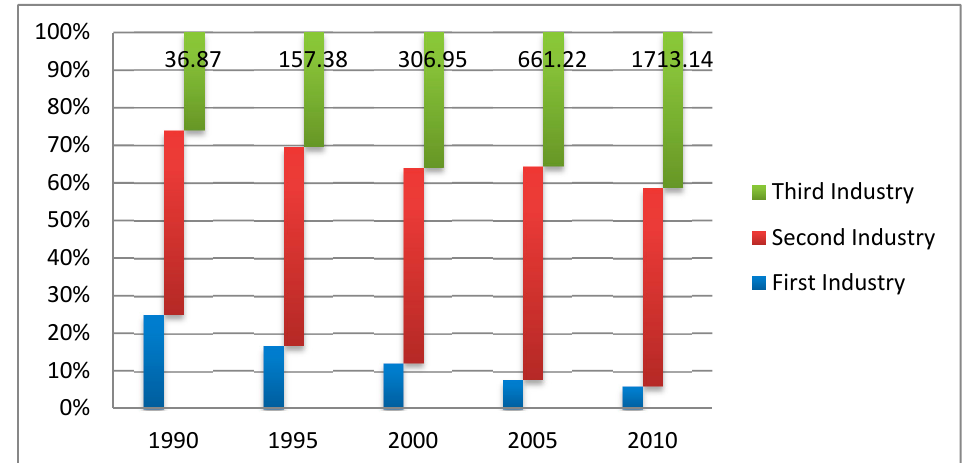
Figure 6. Industrial structure of Jiangsu province expressed by gross domestic product from 1990 to 2010.